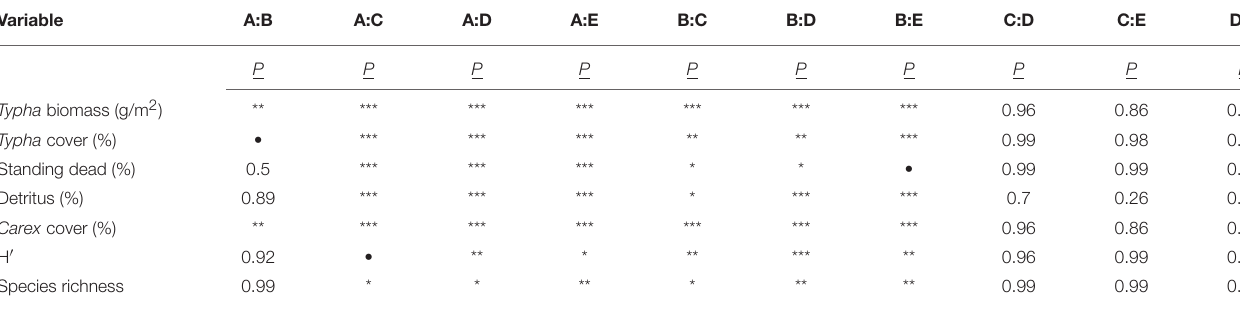
TABLE 4 | Pairwise comparison by subplot determined by LME model (with Typha stand as a source of random effects) and Tukey post-hoc tests.